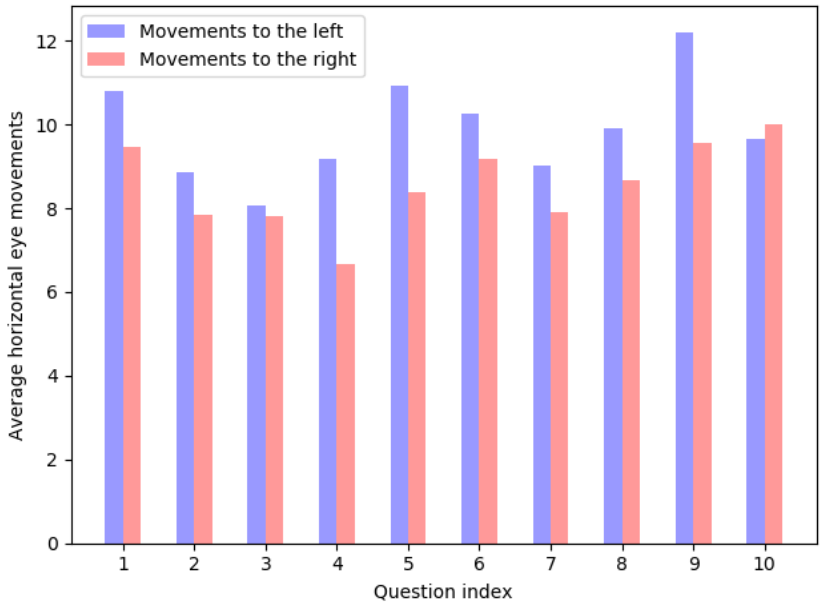
Figure 11. Average lateral saccadic gaze shifts on the Silesian face database. The subjects told the truth on questions 1, 2, and 9 and lied for the other